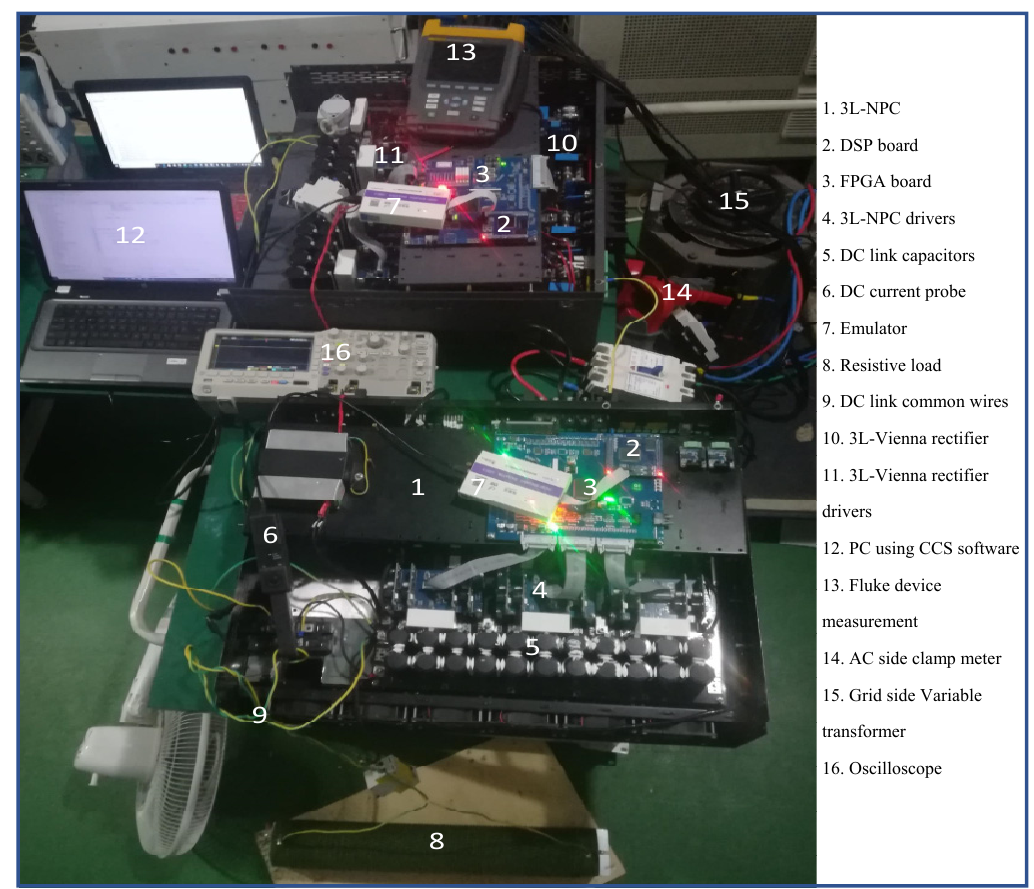
Figure 10. Experimental setup of two parallel-connected 3L-NPC and Vienna rectifier